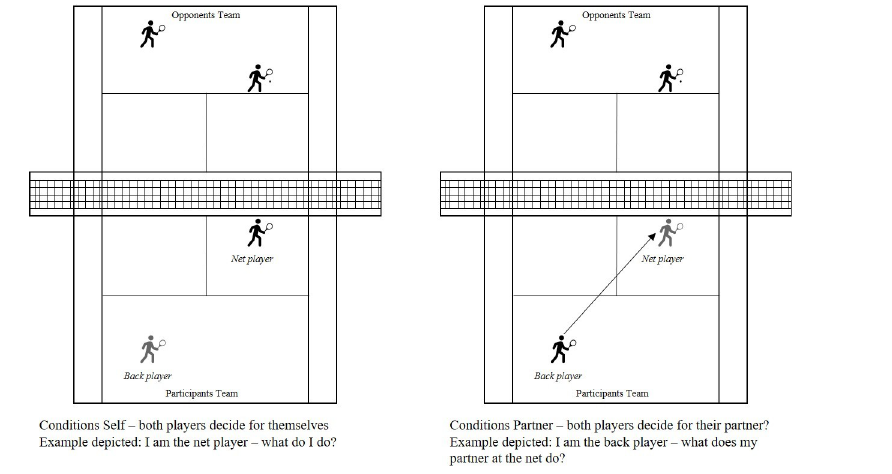
Fig 1. Illustration of task situation and the different